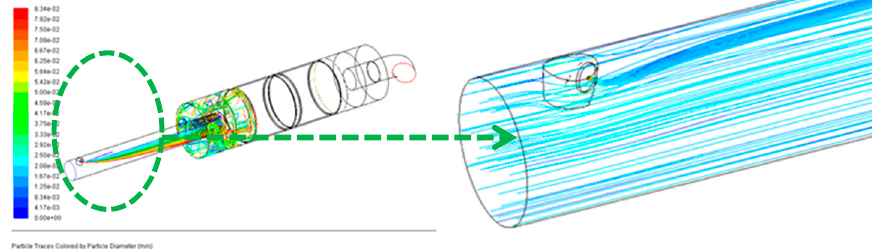
Figure 8. Droplet distributions and streamline distribution of the optimized nozzle.